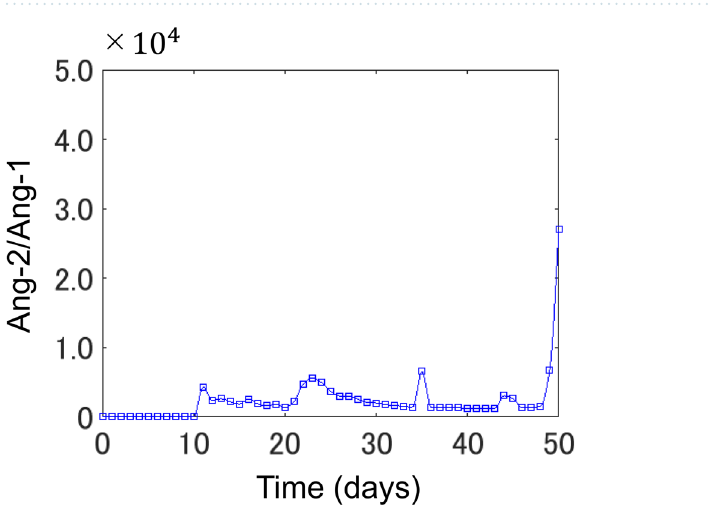
Figure 3. Time-course of new vessel length. ( a ) Changes in the length of new vessels during the 60-day tumour angiogenesis simulation. ( b ) Changes in the length of new vessels during the 60 day tumour angiogenesis simulation, in the absence of angiopoietin-induced regression. ( a , b ) The x- and y-axes show time and length, respectively, of new vessel length.